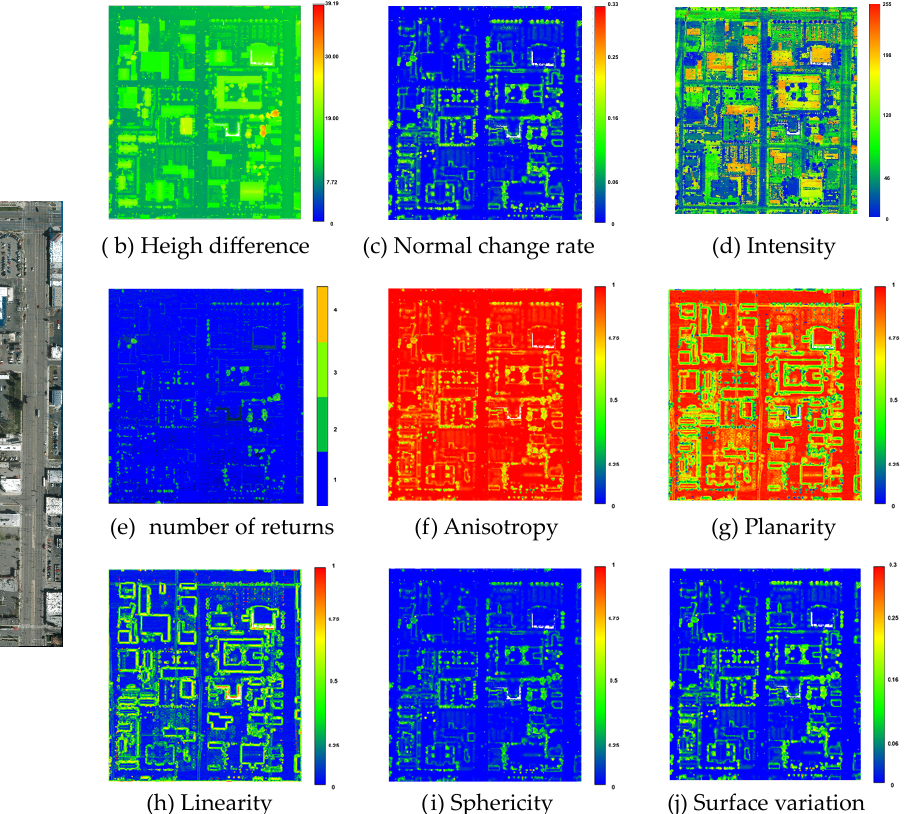
Figure 3. Original point cloud and some representative LiDAR point cloud